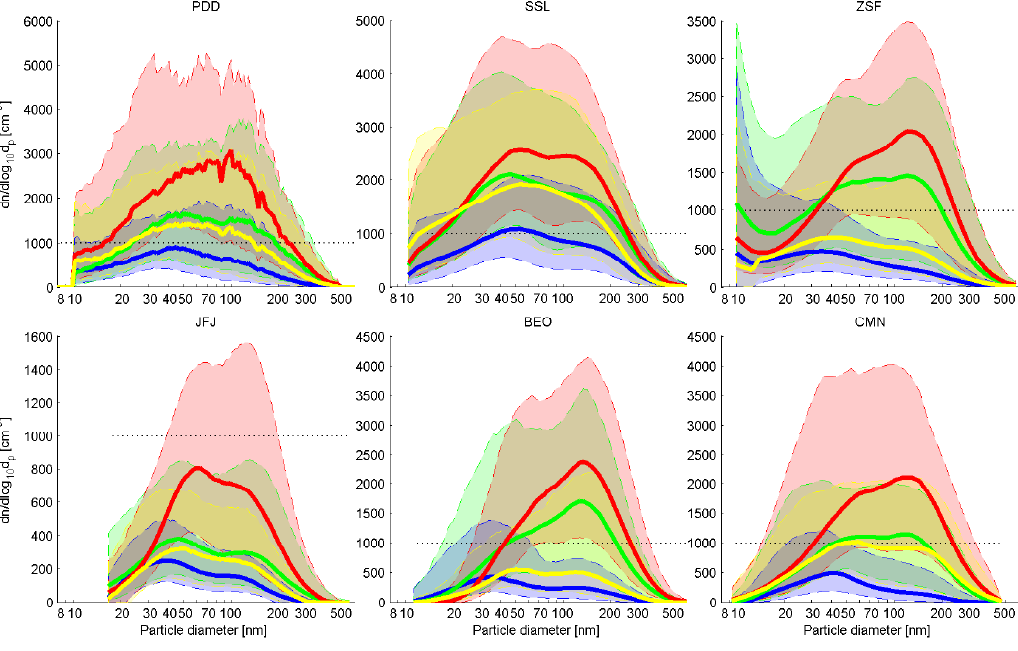
Fig. 6. Median distributions (solid line) and 16th and 84th percentile distributions (shaded areas) divided by seasons at high altitude stations. Notation as in Fig. 4.